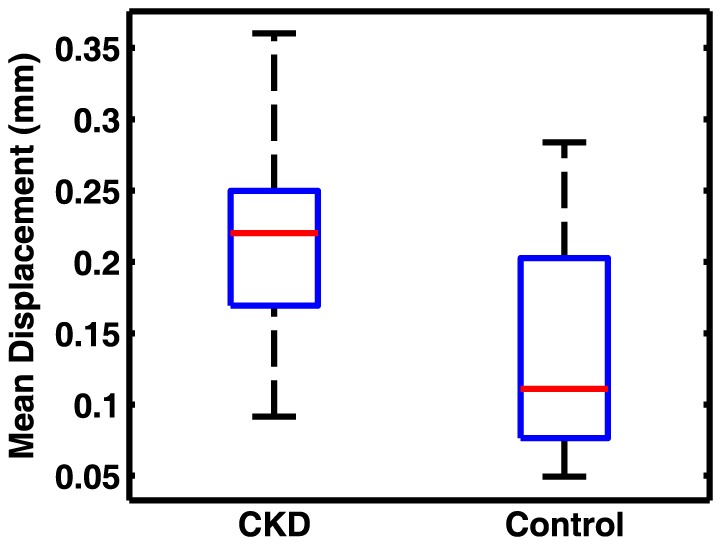
Mean head displacement (mm) before correction during the scan for CKD and control cohorts (p = 0.07).